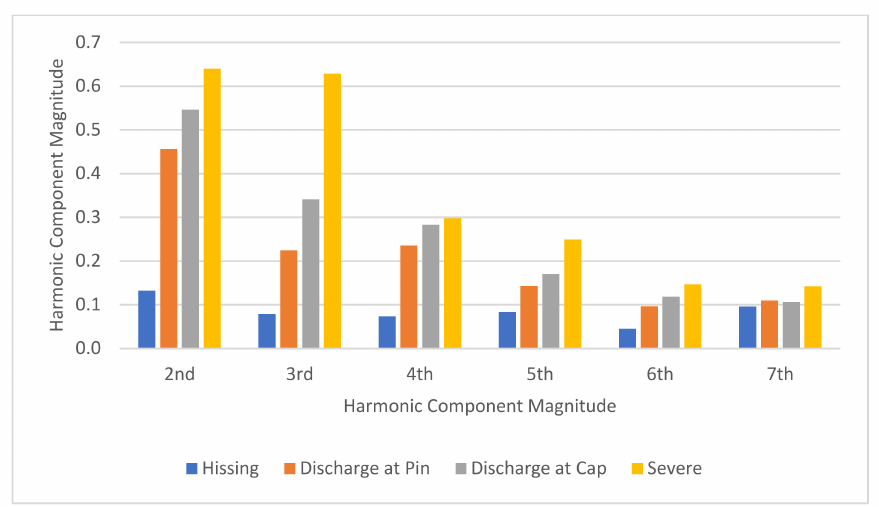
Figure 15. The harmonic component magnitude for each discharge intensity